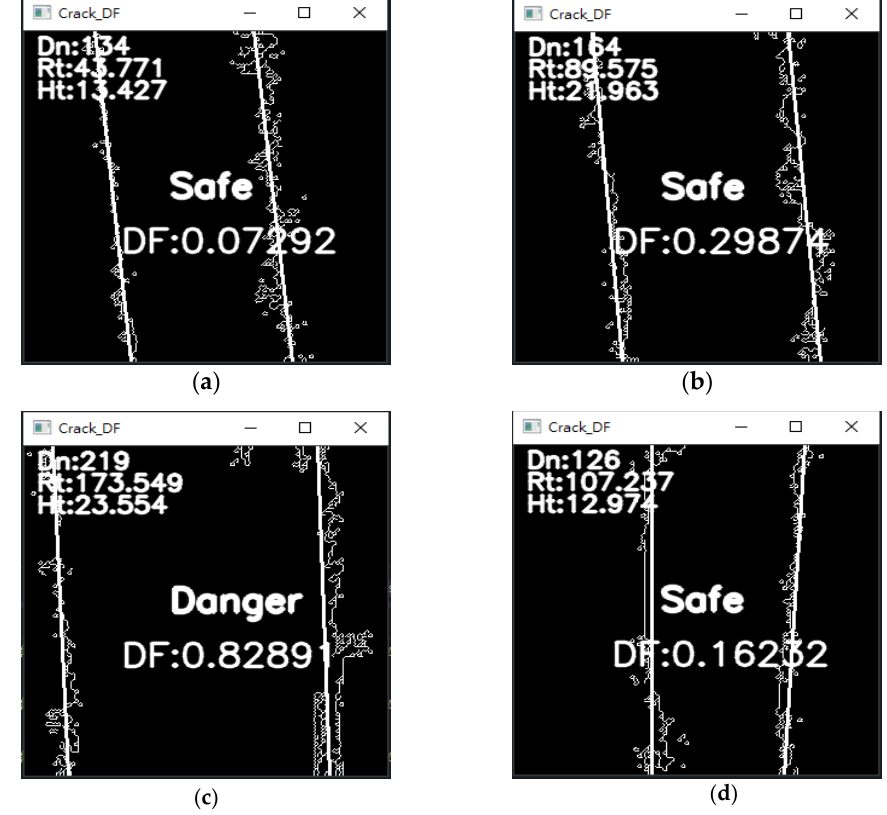
Figure 19. ( a ) No. 26 non-dangerous gap evaluation results. ( b ) No. 57 non-dangerous gap evaluation results. ( c ) No. 67 non-dangerous gap evaluation results. ( d ) No. 76 non-dangerous gap evaluation results.